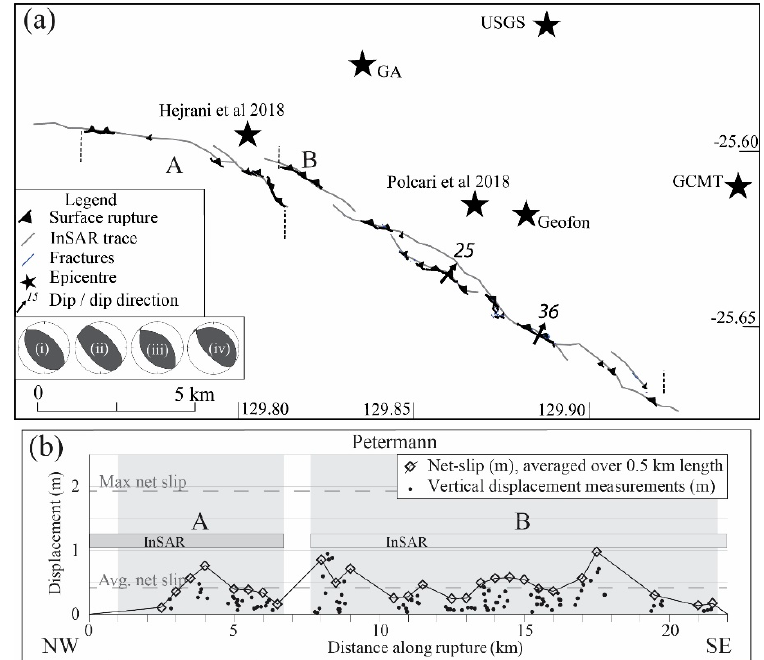
Figure 10. 2016 Mw 6.1 Petermann earthquake ( a ) rupture and fracture map of Petermann scarp [73] showing published epicenter locations and dip measurements of rupture (also the location of hand-dug trenches), focal mechanisms (i–iii) as described in [73], (i) USGS, (ii) GCMT, (iii) Geofon, and (iv) from Hejrani and Tkalcic 2018; ( b ) graph of along-rupture vertical displacement measurements and net slip calculated from available data averaged over 0.5 km increments.